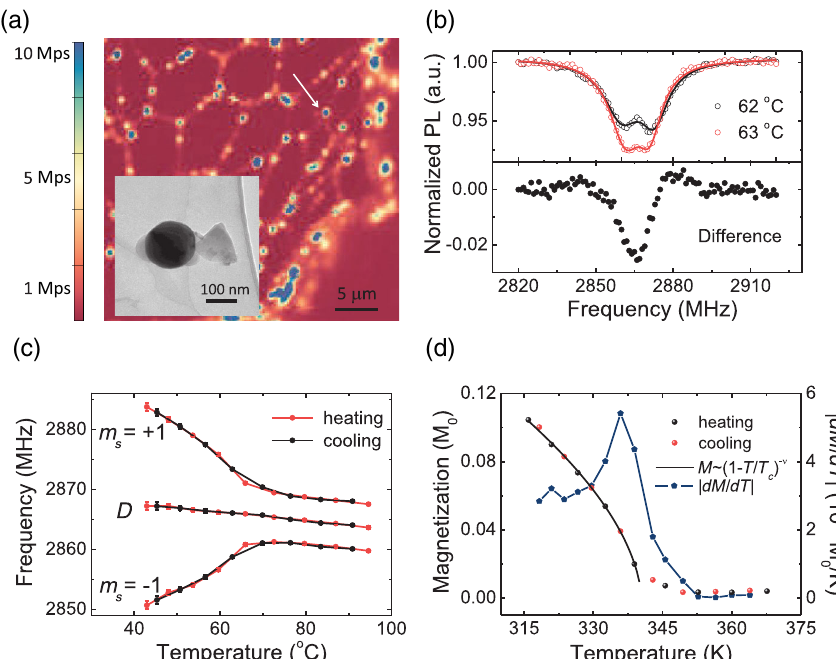
FIG. 4. Magnetic criticality enhanced hybrid nanothermometer. The nanothermometer is composed of a FND (with about 500 NV centers inside) and a nearby Cu 1 − x Ni x MNP. (a) Confocal image of the hybrid sensor (at the arrowhead). The inset shows the TEM image of the measured sensor, in which the CuNi MNP is black and the FND is transparent. (b) Typical ODMR spectra of the hybrid sensor at two different temperatures. The splitting is caused by the magnetic field from the MNP since no external magnetic field was applied. Lower panel is the signal difference of the two ODMR spectra in the upper panel. (c) ODMR resonant frequencies of the m ¼ 0 ↔ m ¼ (cid:2) 1 transitions as functions of temperature. The zero-field splitting D is obtained by averaging the two frequencies. S S Both heating (red dots) and cooling (black dots) processes were measured. (d) The spontaneous magnetization of the MNP extracted from the ODMR spectrum. The red and black dots are measured in the heating and cooling processes, respectively. The blue curve shows the temperature susceptibility of the magnetization. The transition temperature of this nanoparticle is about 340 K, which is consistent with its chemical composition (Cu 0 Ni 0 ) measured by energy-dispersive X-ray spectroscopy in the . 26 . 74